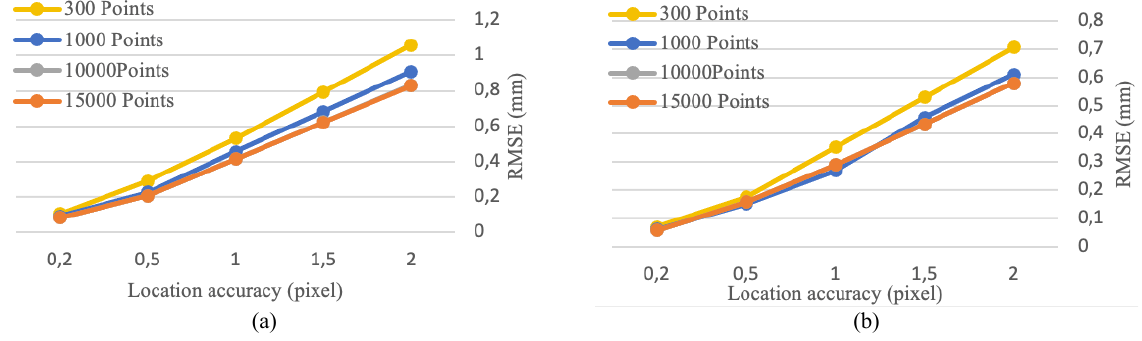
Figure 7 . Achieved RMSE of 3D points when location uncertainity is changing. Closed block with 13 images (large baseline - a) and 26 images (short baseline - b).